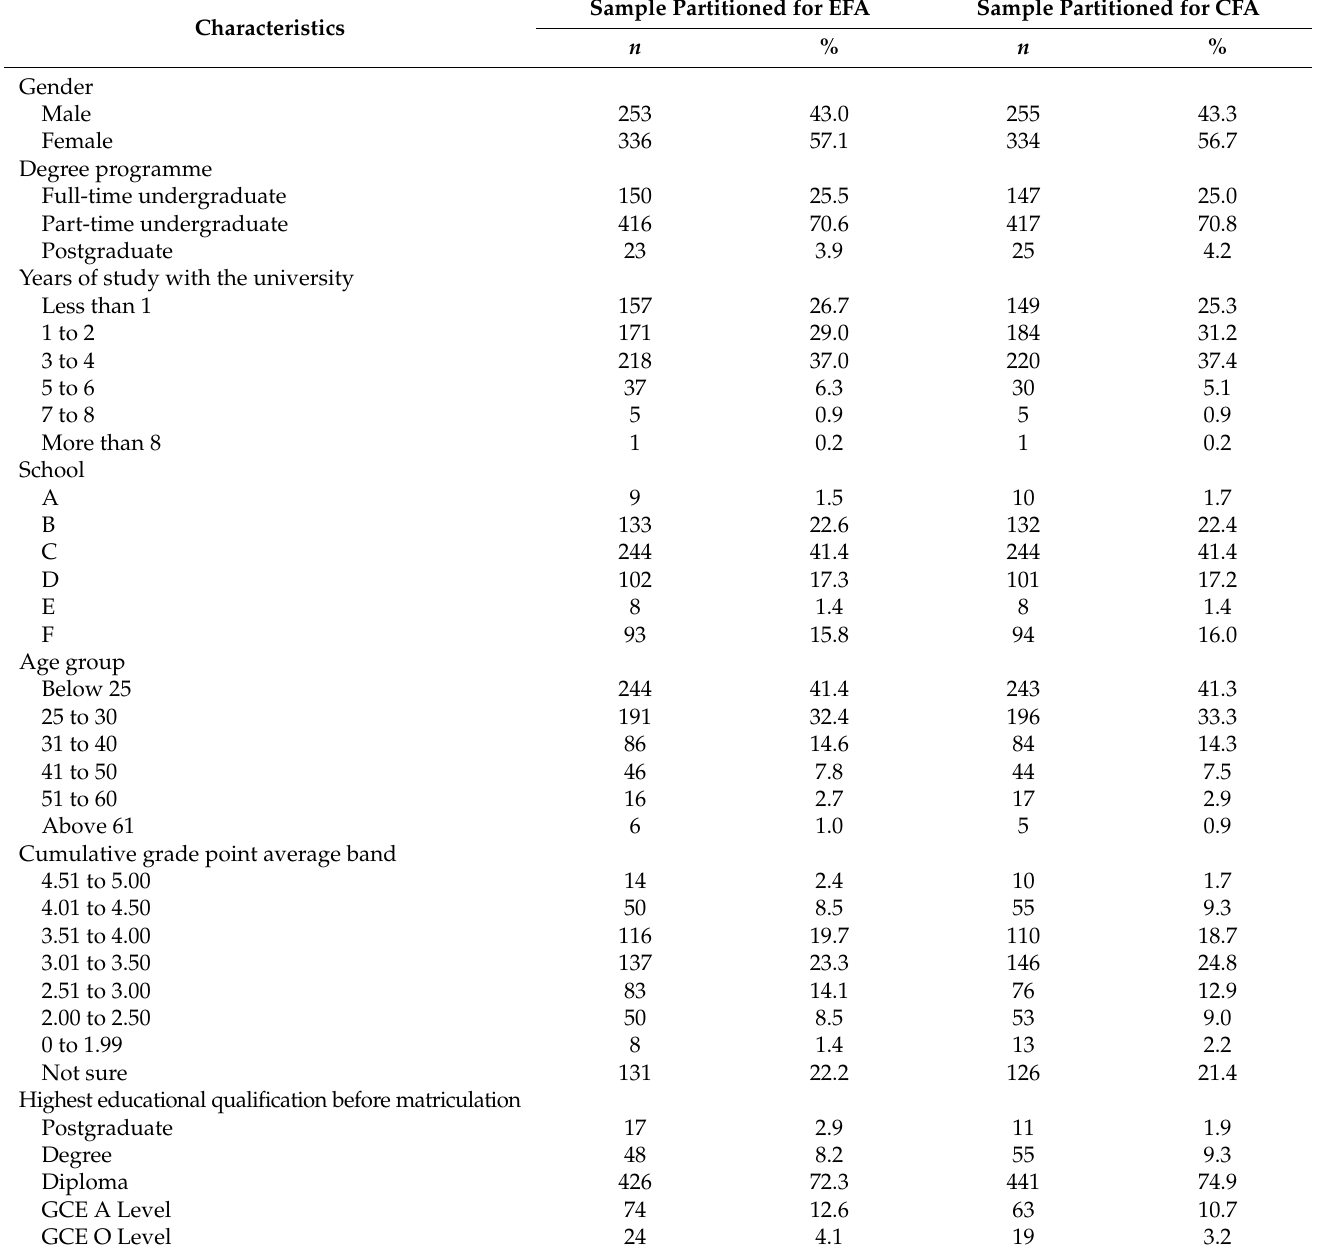
Table 2. Profile of